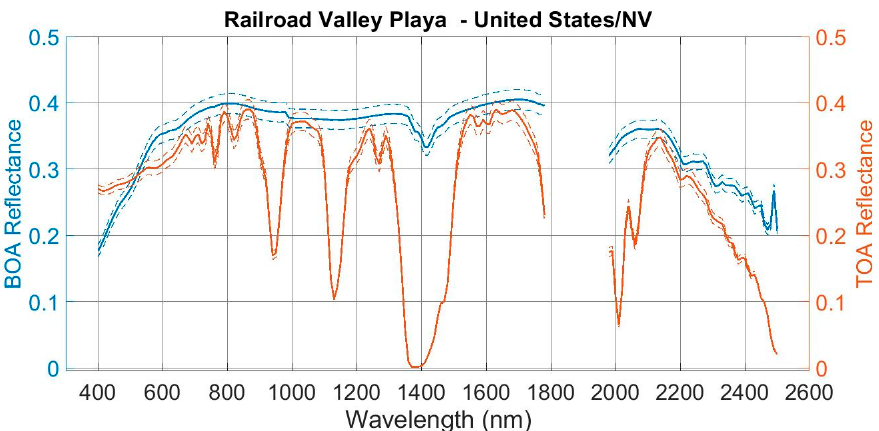
Figure 6. In the y -axis left and right side of the graph is presented, respectively, the BOA and TOA reflectance of Railroad Valley Playa (RVUS) measured in-situ on 2 January, 2020.